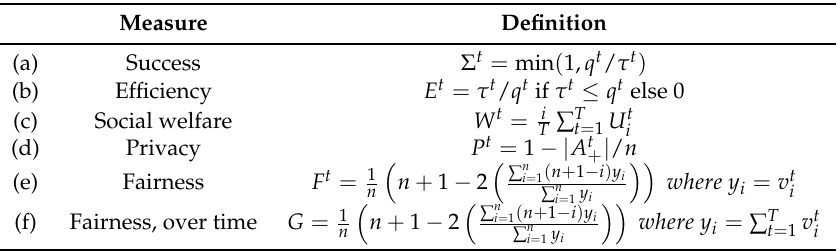
Table 3. Measures used during